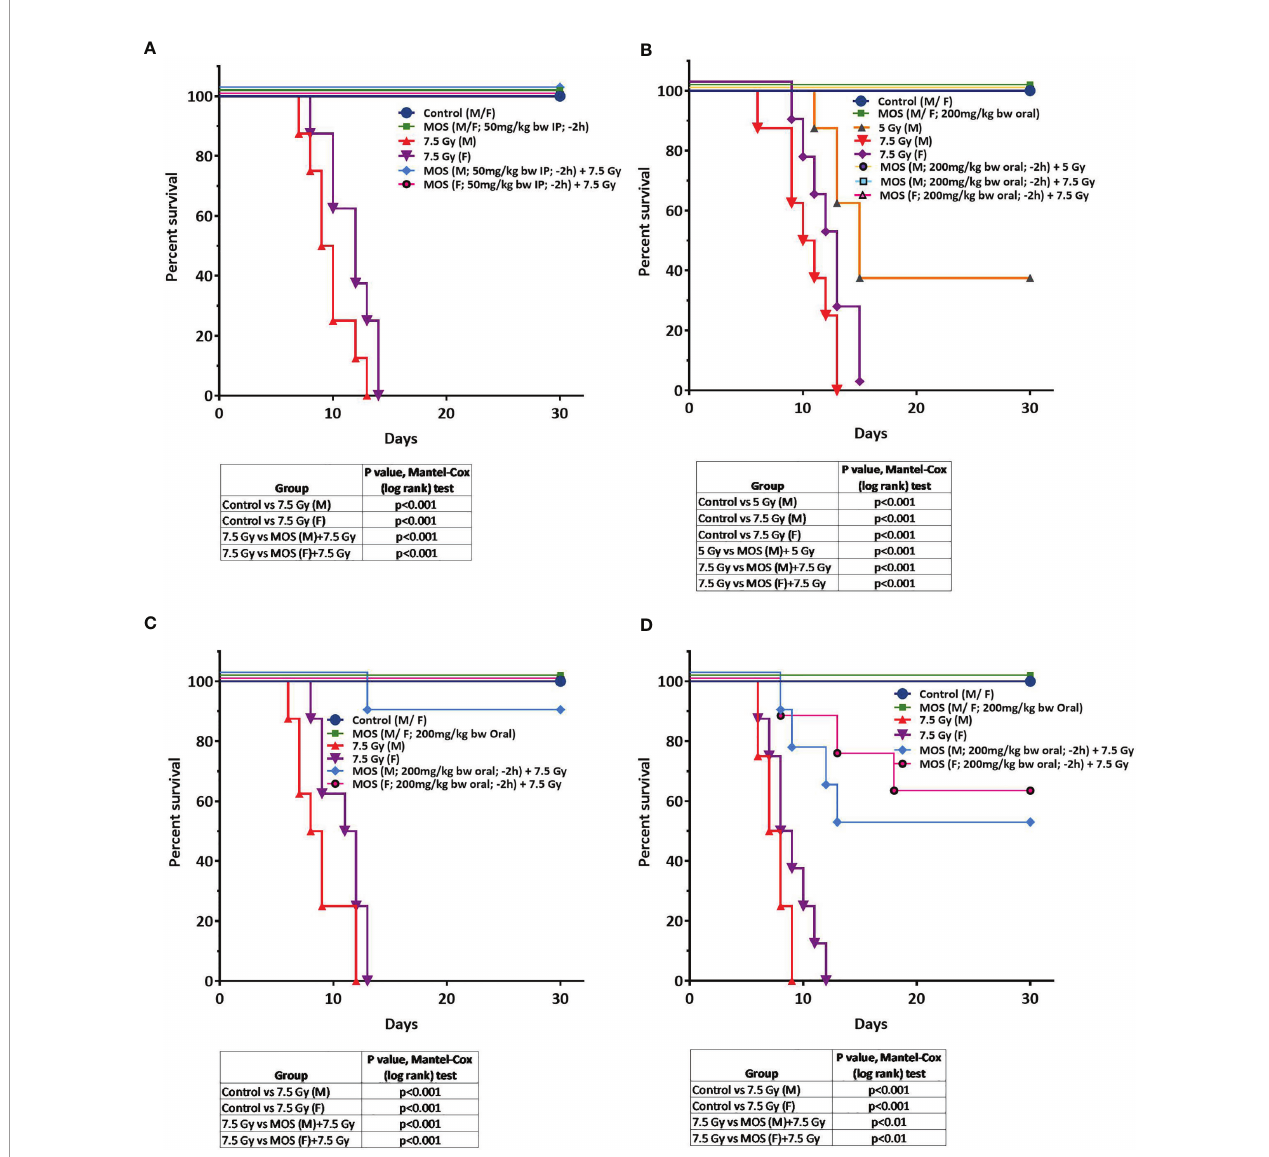
FIGURE 1 | (A – D) MOS pretreatment protects mice from TBI-induced lethality. Protective effects of MOS ( i.e. administered 2 h prior to irradiation) against lethal TBI (7.5 Gy). (A) Mice (8 to 12 weeks old, both male and female) were injected MOS (50 mg/kg/B.W.; i.p.) and irradiated 2 h post treatment. (B) Protective effects of MOS ( i.e. administered orally 200 mg/kg B.W.; 2 h prior to irradiation) against lethal TBI (7.5 Gy) and sub-lethal TBI (5 Gy). Mice (8 to 12 weeks old, both male and female) were administered MOS orally and irradiated 2 h post treatment. (C) Mice (6 – 8 months old, both male and female) were administered MOS orally (200 mg/kg B.W.) and irradiated 2 h post treatment. (D) Mice (12 – 13 months old, male) were administered MOS orally (200 mg/kg B.W. and irradiated 2 h post treatment. Kaplan – Meier survival curve depicts the 30-day survival (n = 8 in all the groups). The table summarizes the fi ndings of Mantel – Cox (log-rank) test comparing survival responses between un-irradiated and TBI cohorts, TBI and MOS ( − 2h) +TBI